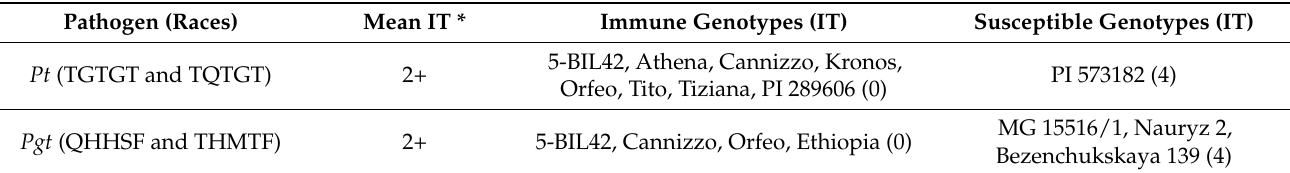
Table 1. Descriptive statistics of Pt and Pgt infection types at the seedling stage.